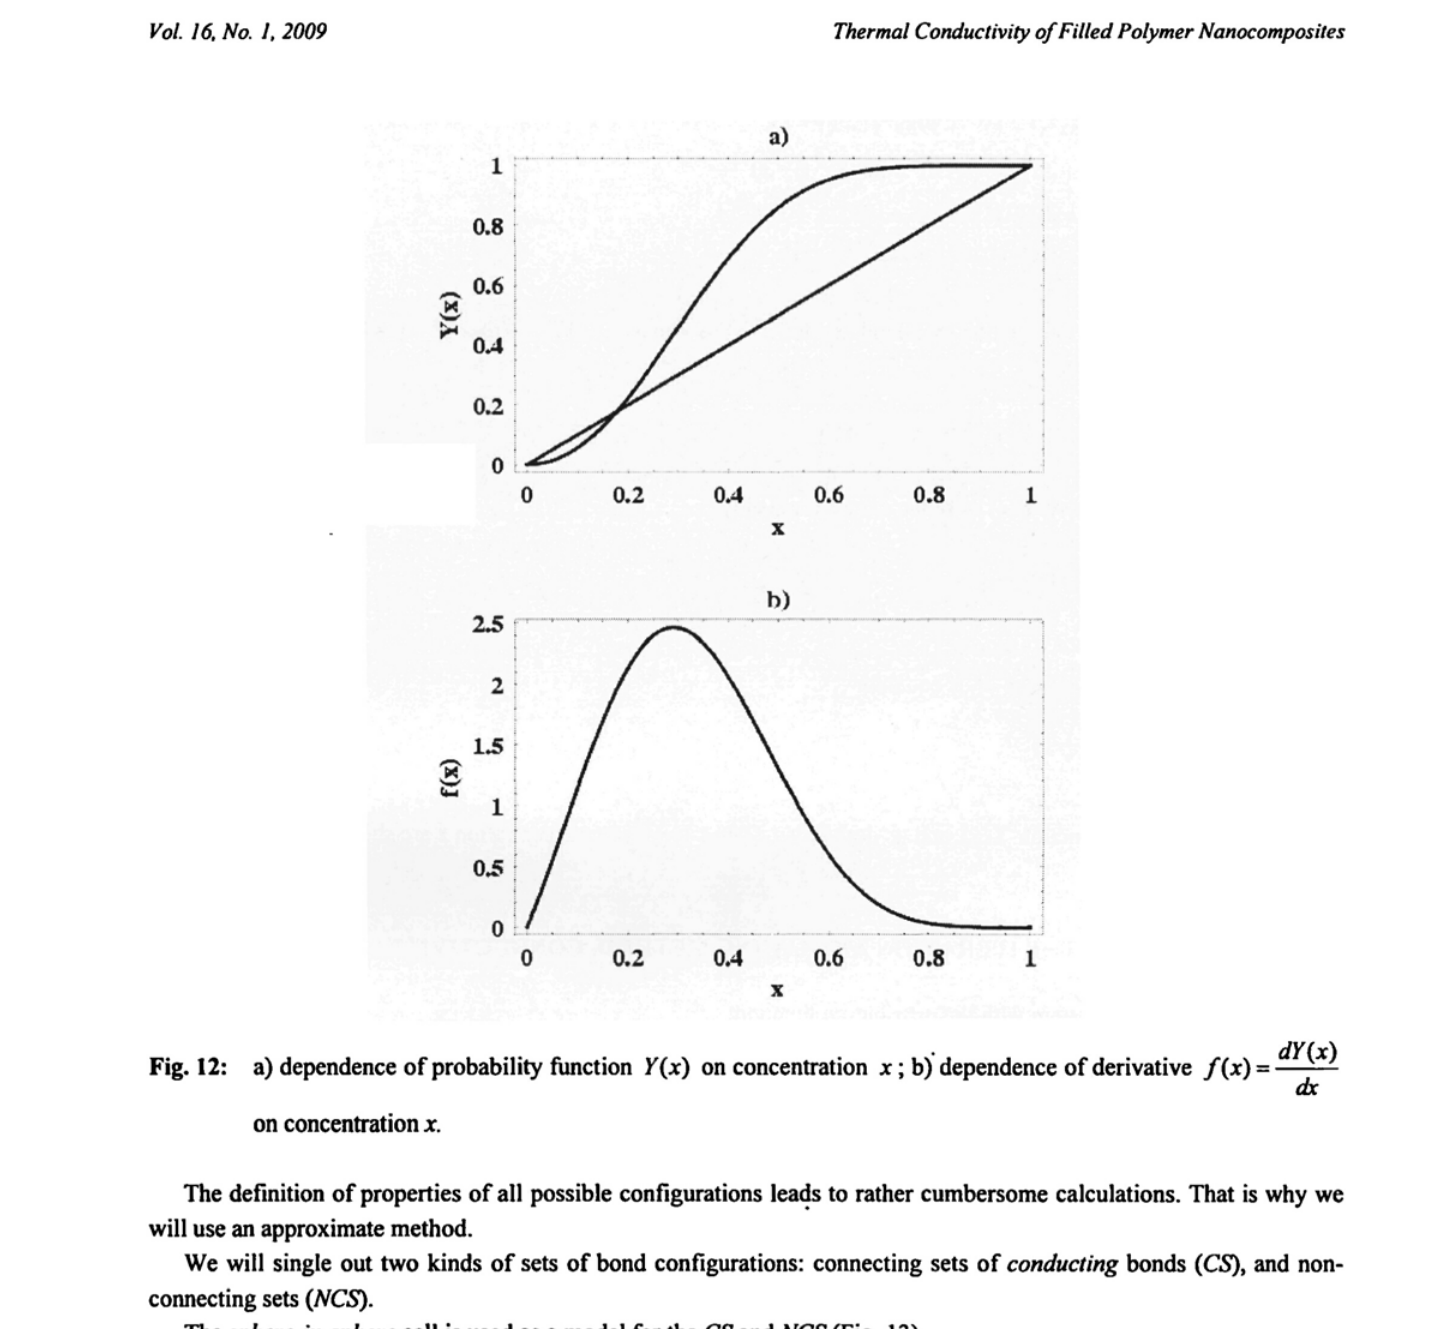
Fig. 12: a) dependence of probability function Y(x) on concentration χ ; b) dependence of derivative f(x) = on concentration x.